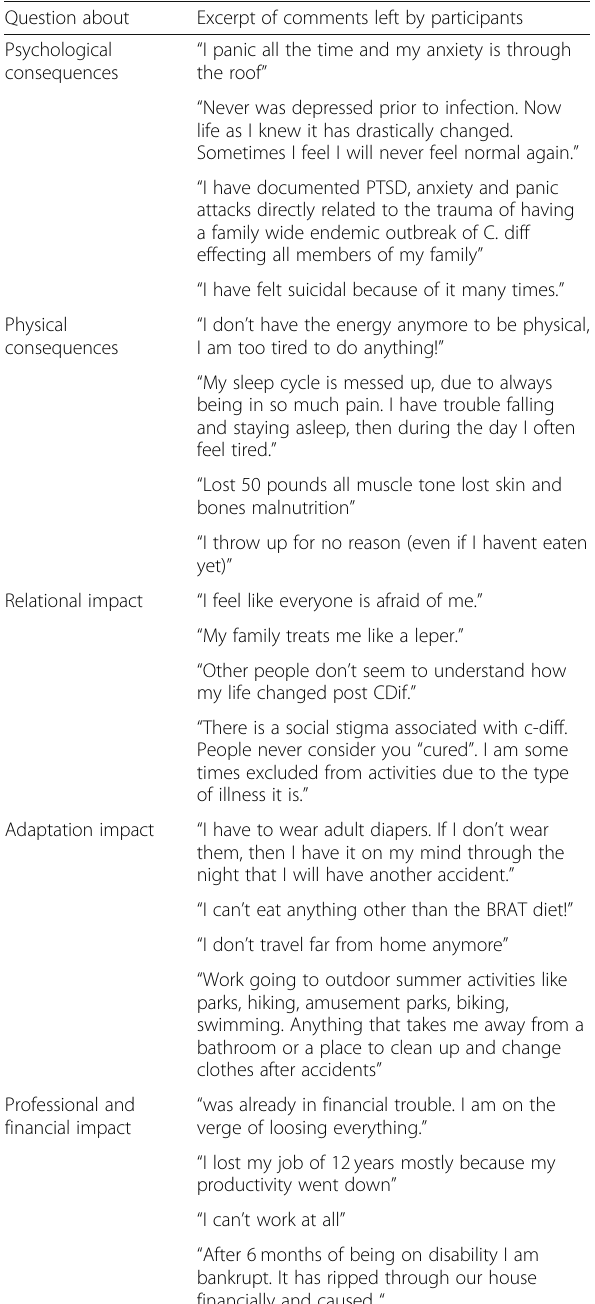
Table 4 Illustrative quotes left by participants in the